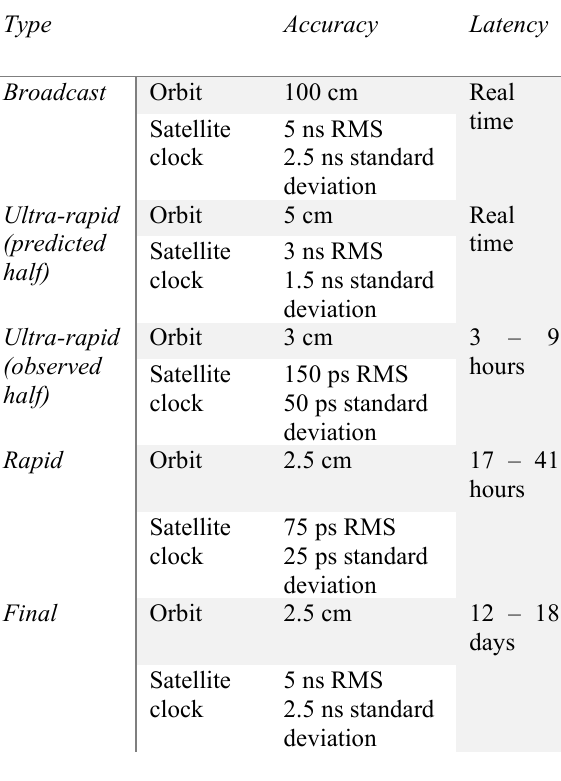
Table 1. Accuracy and latency of ephemerides (Johnston et al., 2017)